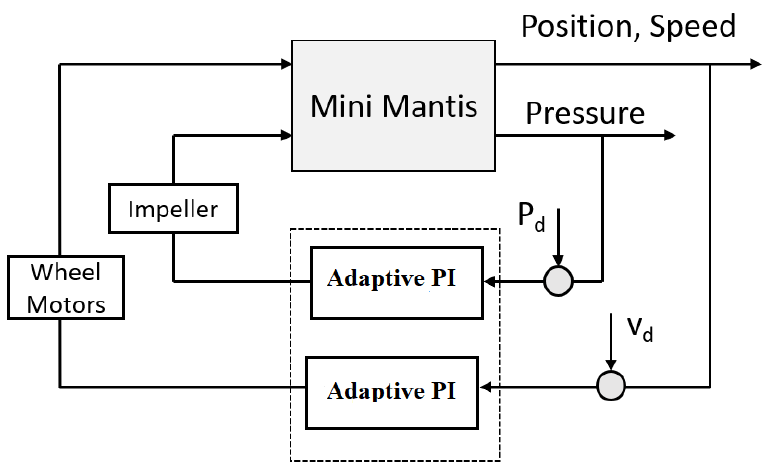
Figure 19. Control